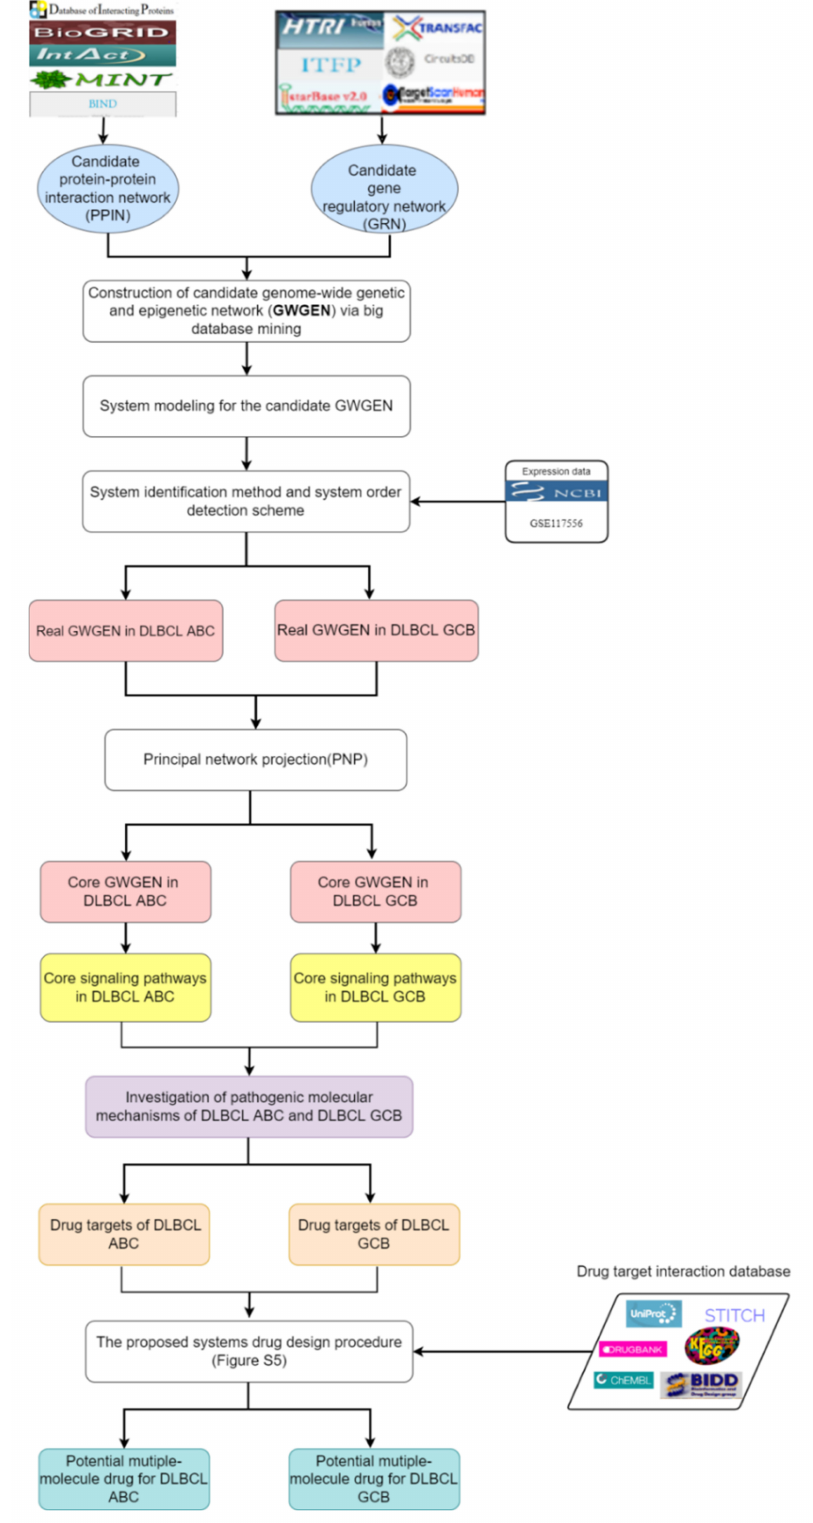
Figure 1. Flowchart of systems drug discovery based on systems biology approaches and drug design